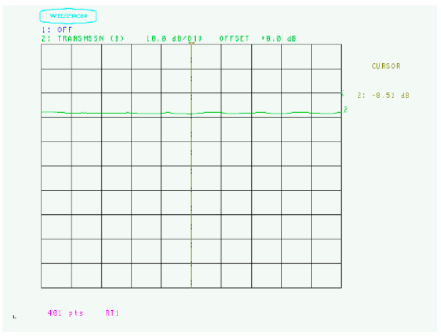
Figure 21. Radio wave absorption of sample material created by our CNT spray method (8.51